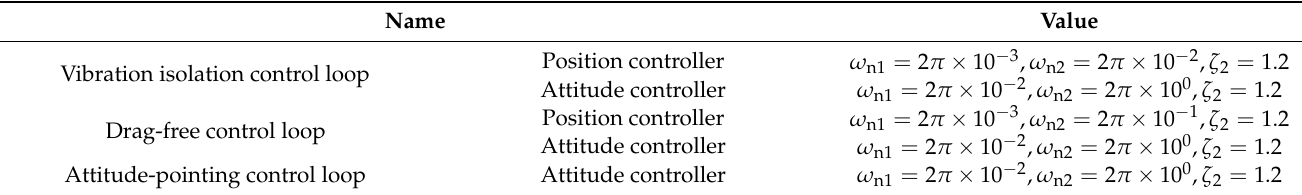
Table 3. Controller parameters of the improved DFP